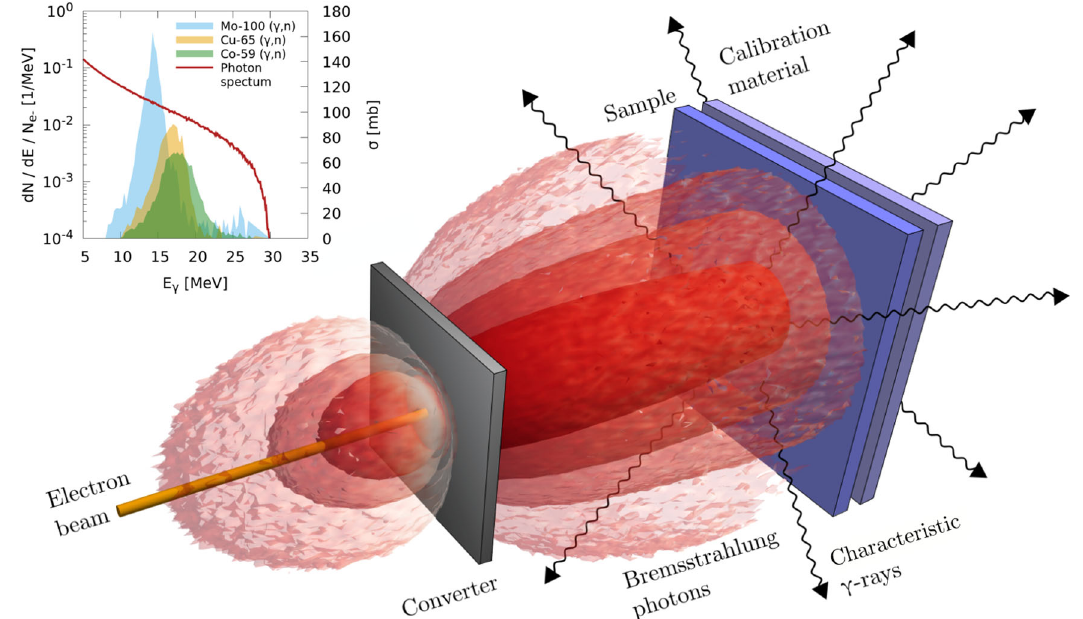
Fig. 1 Conceptual setup of photon activation analysis. The red line is the bremsstrahlung photon energy spectrum obtained from a Fluka simulation performed with 30 MeV monoenergetic electrons and a W converter having a thickness equal to 3 mm. The inset graph reports some examples of ( γ , n ) photonuclear cross sections (from the evaluated nuclear data fi le (ENDF) database 67